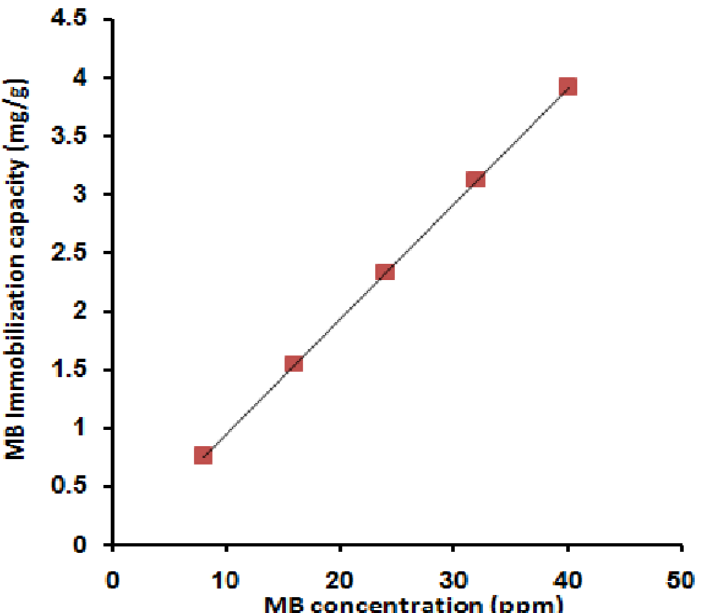
Figure 1. Effect of MB concentration on its immobilization capacity; [MB 10 mL, room temperature, 30 min, 0.1 g SPGMA, rpm 200, and pH 6.5].